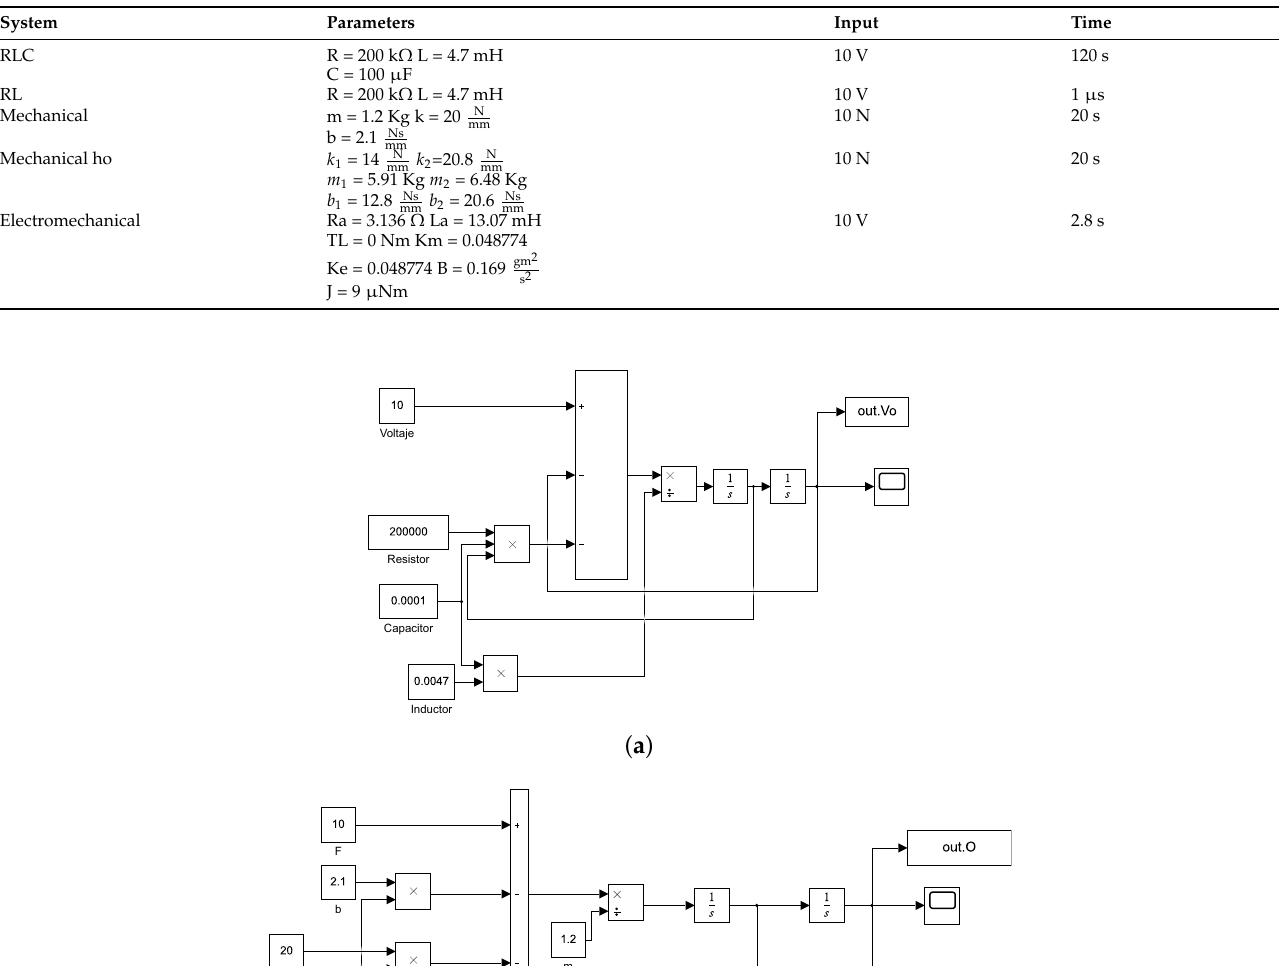
Table 2. Values used for step simulation in different systems.